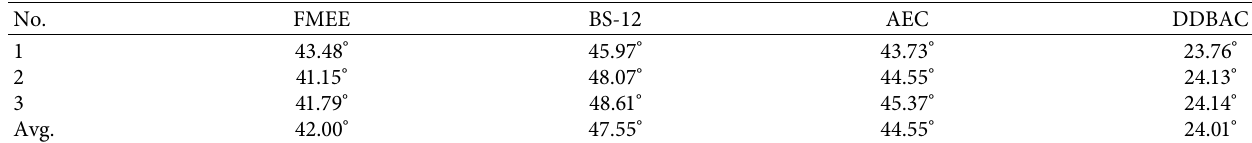
Figure 8: Contact angles of surfactants on the coal sample dust. (a) FMEE 41.79 ° . (b) BS-12 48.07 ° . (c) AEC 43.73 ° . (d) DDBAC 24.13 ° . Table 6: Contact angles of surfactants on the coal sample dust.